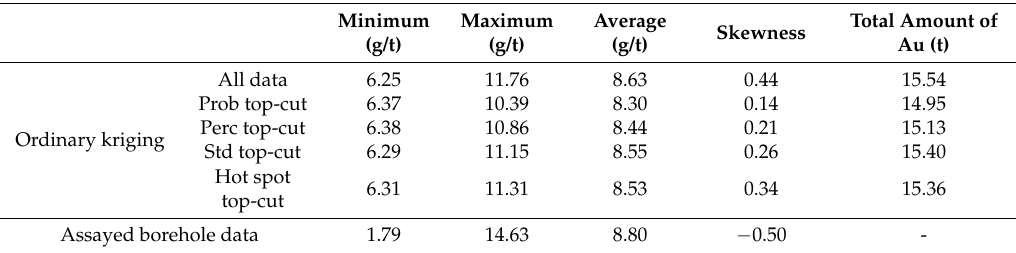
Figure 8. Histograms of Au grade estimation using ( a ) all data or capped data by ( b ) prob top-cut, ( c ) perc top-cut, ( d ) std top-cut, and ( e ) hot spot top-cut, and ( f ) histogram of assayed Au grade data. Table 1. Minimum, maximum, average, skewness, and total amount of Au in the vein for each kriging prediction and assay data.